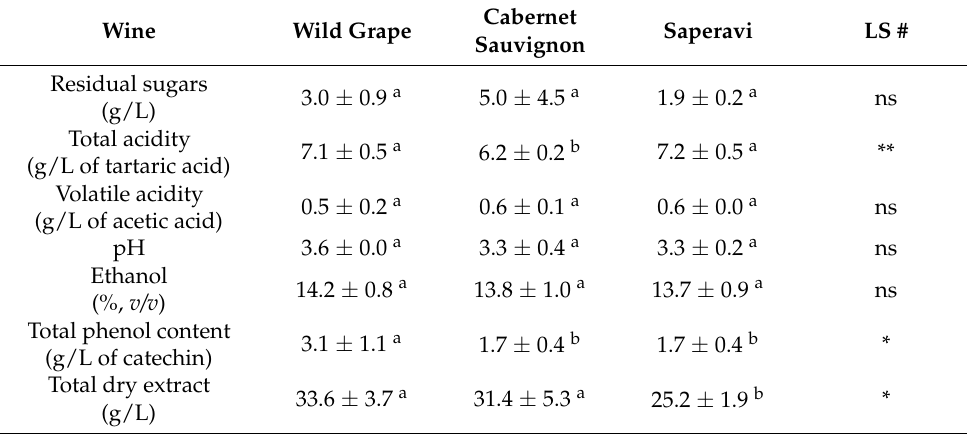
Table 2. Chemical parameters for the wines produced with wild grape, Cabernet Sauvignon, and Saperavi grapes. Data is expressed as average ± standard error of the three (2017, 2018, 2019) vintages investigated. Different letters mean significant differences (F-test). #: LS, level of significance: ns, non-significant; *, p < 0.1; **, p <